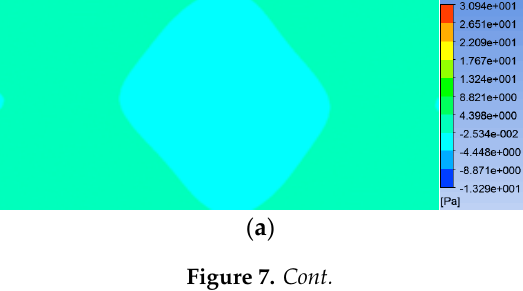
( b ) Figure 7. Strip pressure distribution above and under the strip. ( a ) Above the strip; ( b ) under the strip. 3.2. The Influences of Different Aerodynamic Loads on Strip Midpoint Amplitude and Flatness Calculation Deviation In actual situations in the field, in order to make the strip amplitude within the optimal measurement range of the sensor, the most commonly used and most important method for adjusting the strip amplitude is to change the speed of the air inlet of the SI-FLAT flatness meter. Thus, first, the influence of different aerodynamic loads on the strip midpoint amplitudes was simulated, which provided a reference for setting the excitation force in the field. The rated flow of the fan in the SI-FLAT flatness meter was 125 m 3 /min, and the conversion between the fluid flow and the flow speed is shown in Equation (4): Q (4) where Q is the fluid flow, v is the flow speed, and A is the sectional area of the airflow channel. The rated flow speed of the fan was calculated at 64m/s based on Equation (4), and the actual flow speed was far less than the rated flow speed according to the field data. In the fan speed range that was actually used in field, the midpoint amplitude changes of different thicknesses under different alternating aerodynamic loads (namely the different maximum speeds of the air let) were separately calculated when the width was 2000 mm and the other parameters were unchanged, as shown in Figure 8a. At the same time, the midpoint amplitude changes of different widths under different maximum speeds of the air let were also separately calculated when the thickness was 1 mm and the other parameters were unchanged, as shown in Figure 8b.